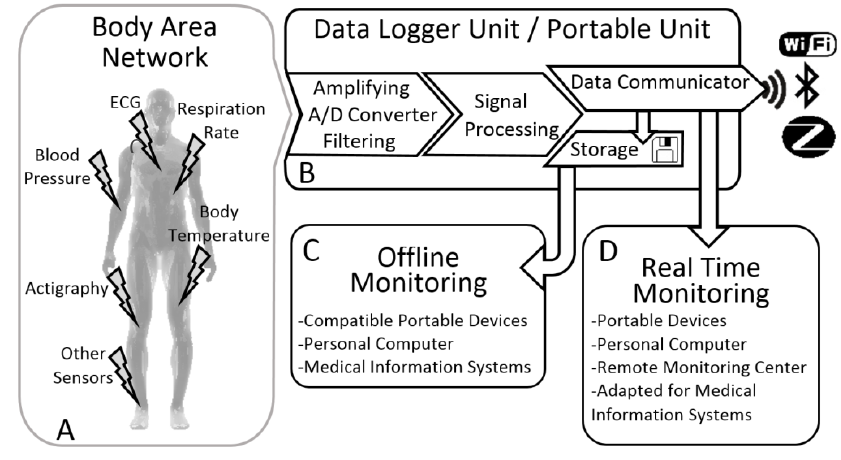
Figure 3. Generic architecture of wearable health devices system [3,10,81 – 83].